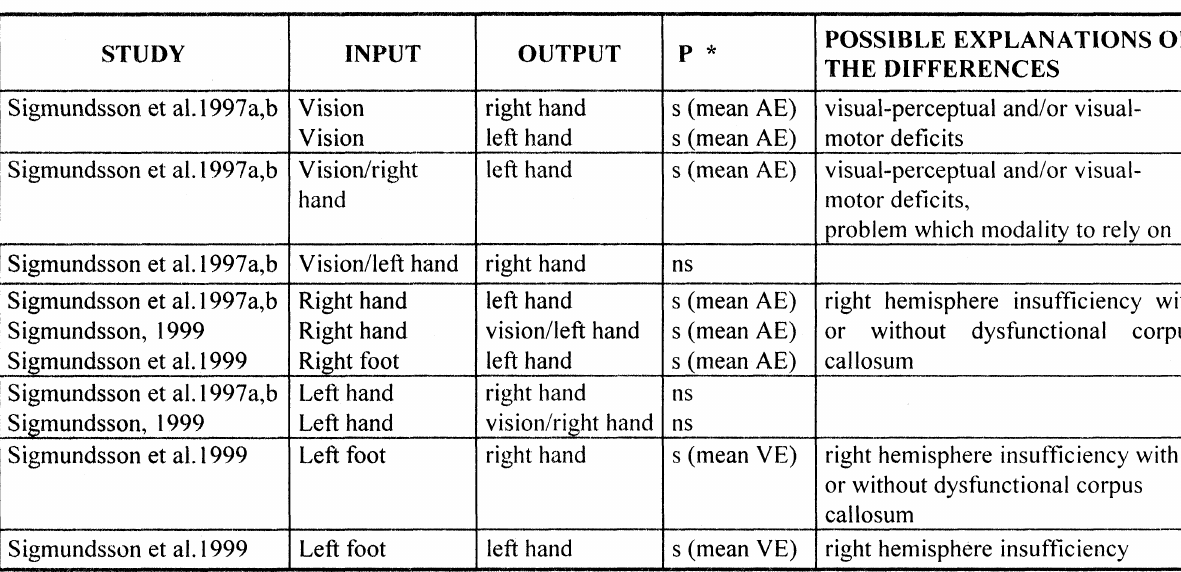
Fig. I:Mean distance target-pin (t-p; millimetres) scores tbr the two conditions of the experiment tbr hand-eye co-ordination problem (HECP) and control groups matching with the right hand (rh) and the left hand (lh) (V vision only: P propriocpetive only) Legend" HECP _-]